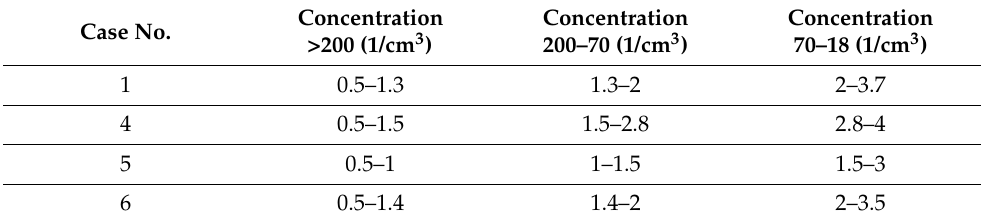
Table 3. Concentration distribution in 5-min particle